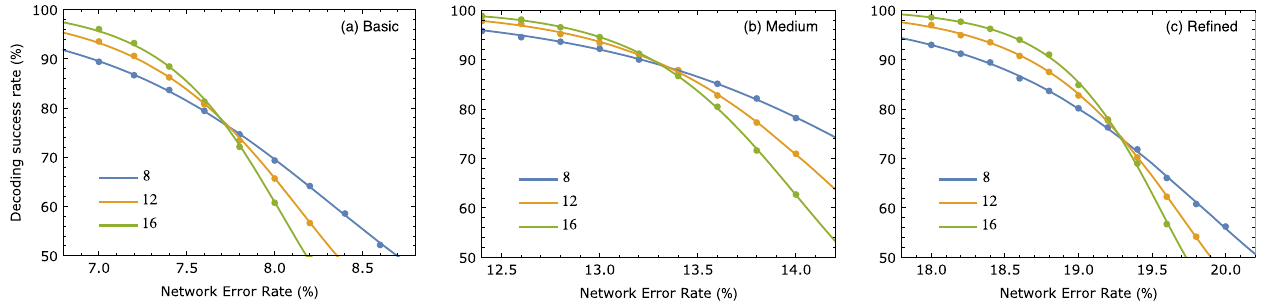
FIG. 9. Thresholds with 1% of stabilizer outcomes missing: (a) Basic, (b) medium, (c)